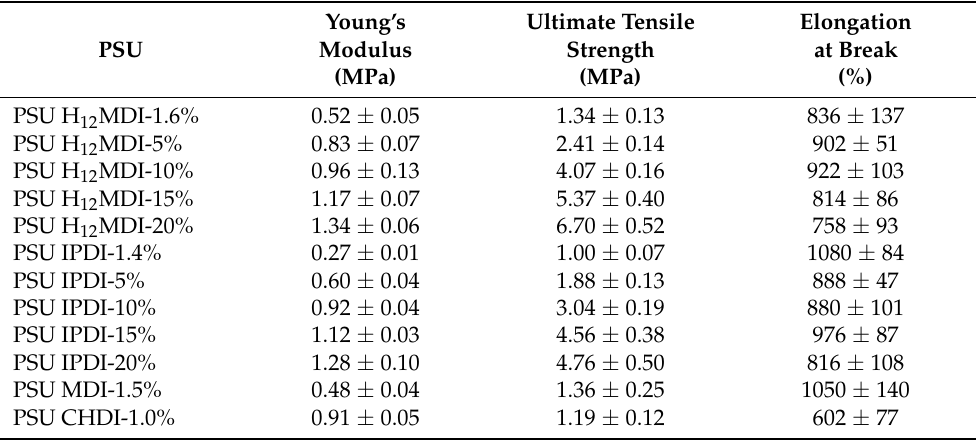
Table A1. Young’s modulus, ultimate tensile strength, and elongation at break of PDMS-based polyurea elastomers synthesized from the aliphatic diisocyanates H 12 MDI, IPDI, and CHDI, and from the aromatic diisocyanate MDI. Values are given as an average of five repeated measurements ± standard